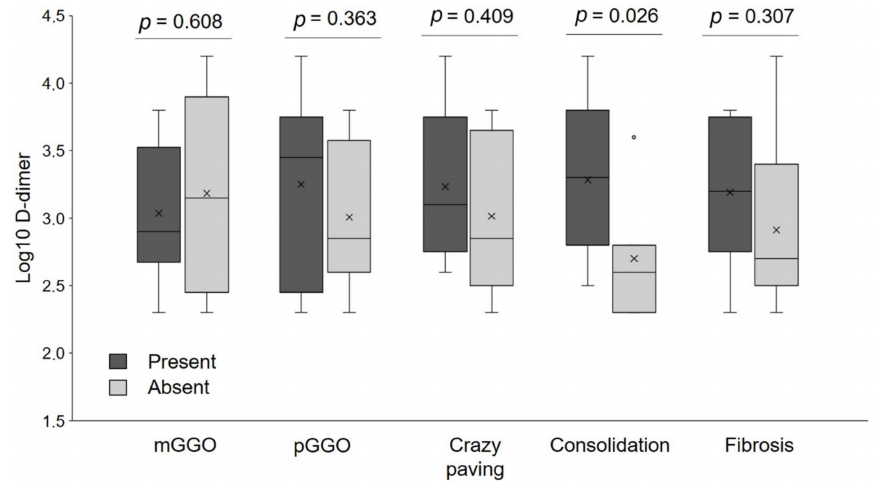
Figure 5. Distribution of D-dimer at admission in patients with different radiological pattern at the chest computed tomography (CT) performed at the time of first evaluation. Note that the only significant difference in D-dimer was in patients with and without parenchymal consolidations. Vertical lines represent the 75th and 25th percentile. Horizontal bars are medians. X signs indicate means. pGGO = peripheral ground glass opacities; mGGO = multifocal ground glass opacities.